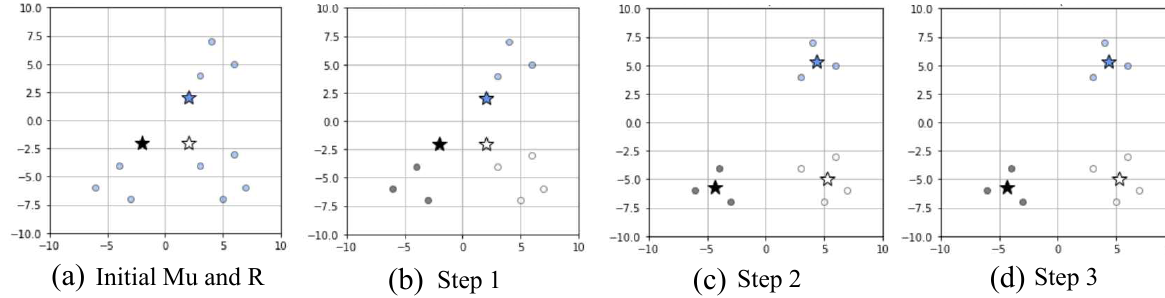
Figure 3. An example of k-means